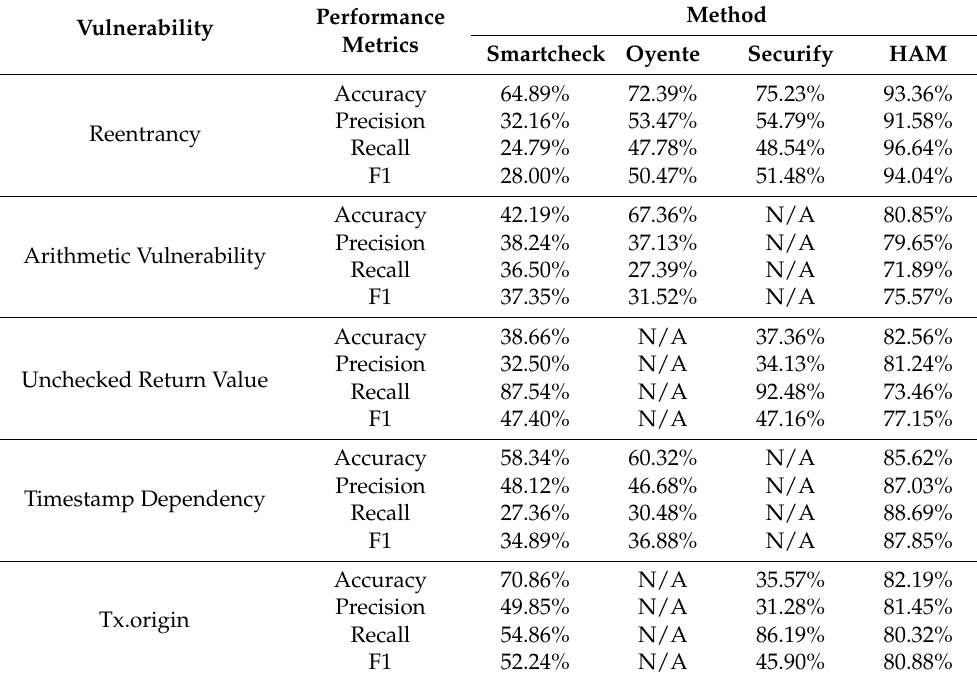
Table 6. Performance comparison with three existing state-of the-art